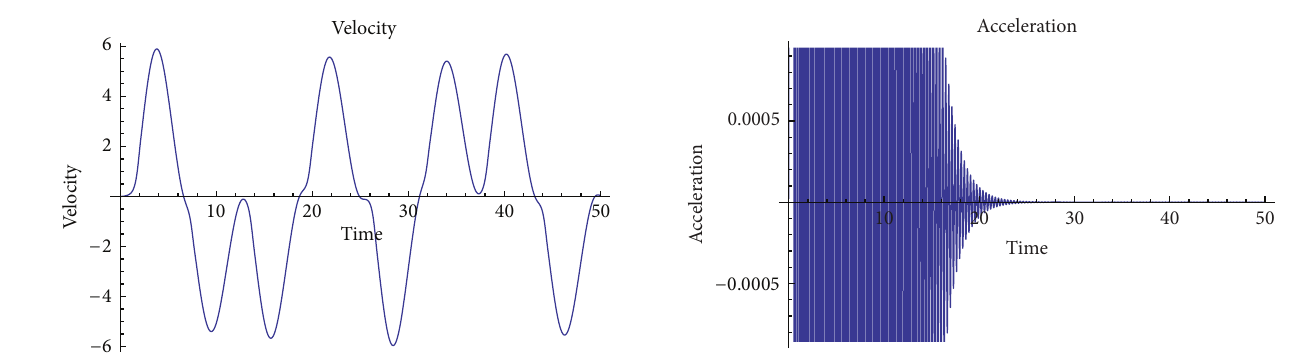
Figure 4: The stabilizing progress of acceleration for 𝜀 = 0.1, 𝐵 = 100, ] = 0 .